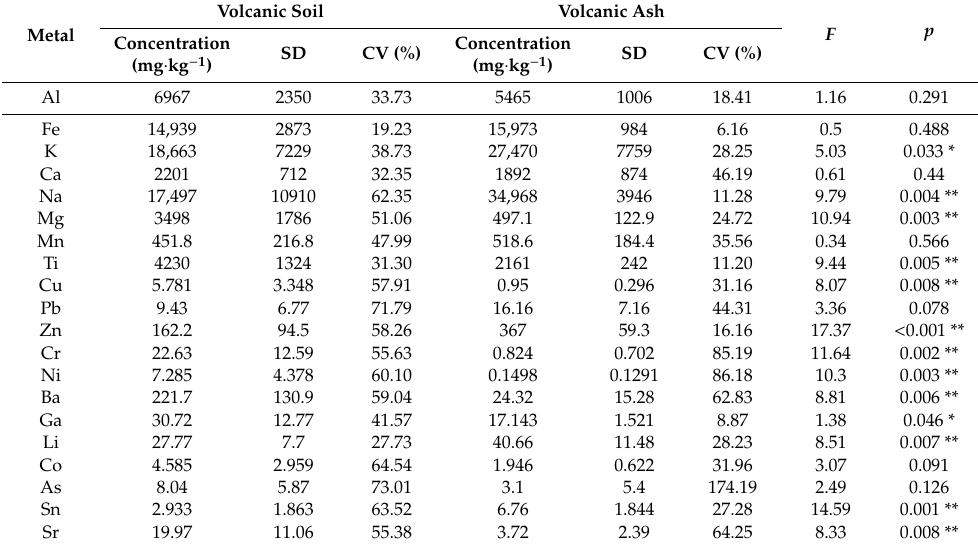
Table 2. Standard deviation (SD), coe ffi cient of variance (CV) and one-way analysis of variance results of metal concentrations in volcanic soil and volcanic